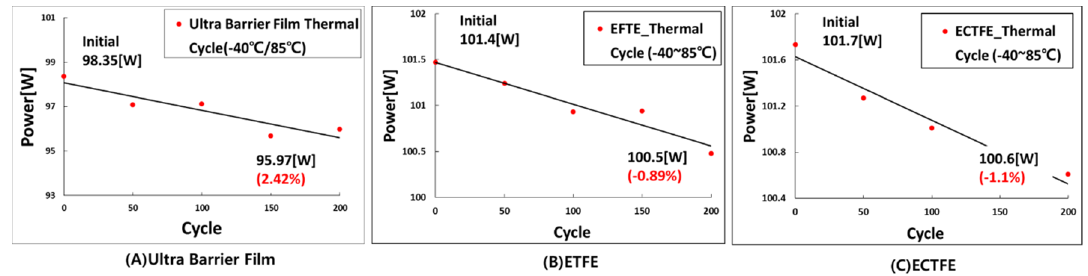
Figure 8. The result of the thermal cycle test of the PV module with the film applied to the front surface ( A ) Ultra-barrier film ( B ) ETFE and ( C ) ECTFE.